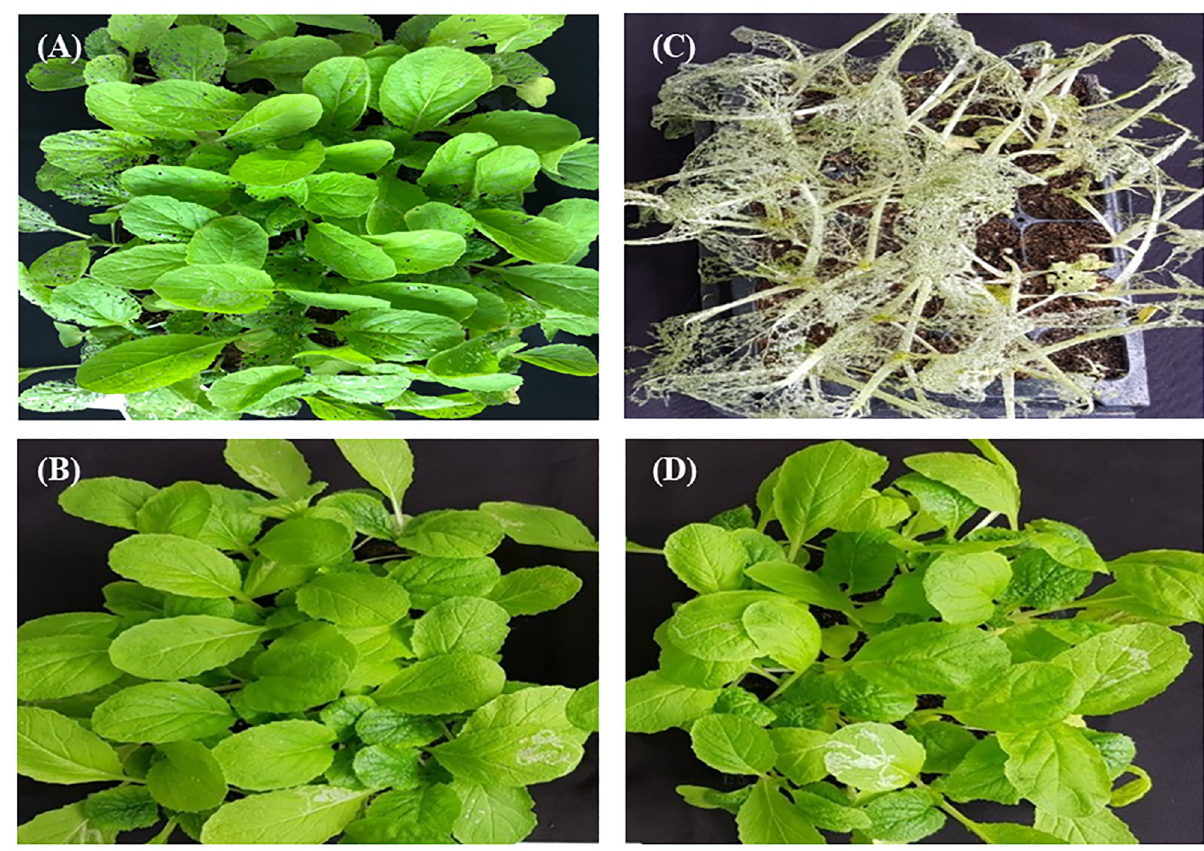
Fig 4. The ovipositional repellency and larvicidal activity of Streptomyces sp. KR0006 against diamondback moth. The culture filtrate was first sprayed on the cabbage seedlings grown in the tray, and then 50 diamondback moths were inoculated. Six days after inoculation (DAI), the culture filtrate was secondarily applied to half of the tray. (A); 6 DAI control, (B); 1 st treatment of broth filtrate, (C); 10 DAI control, (D); 2 nd treatment of broth